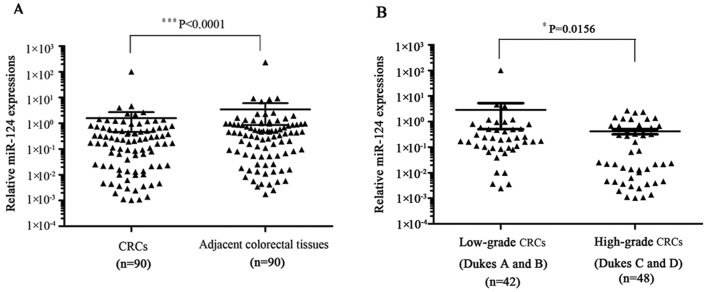

MiR-124 is down-regulated in human CRC.(A) qRT-PCR analysis on the expression of miR-124 in CRC compared to adjacent nonmalignant colorectal tissues from 90 patients (P<0.0001). PCR reactions were performed in triplicates with RNU6B as internal control. (B) Association of miR-124 expression level with CRC progression (P = 0.0156).